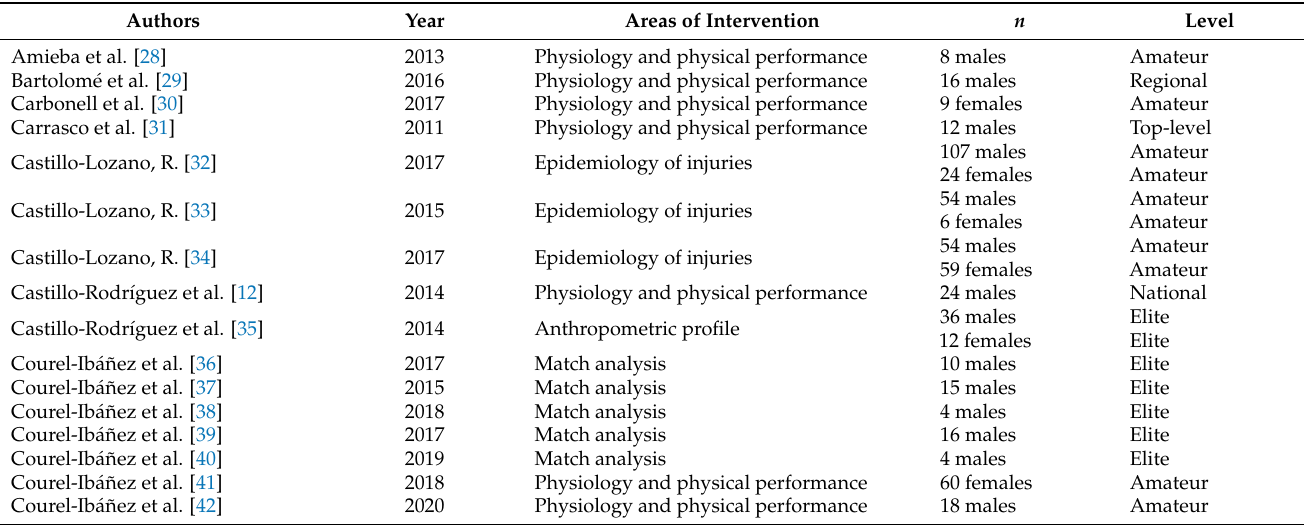
Table 1. Studies included in the review, authors, year of publication, areas of intervention, number, gender, and level of the